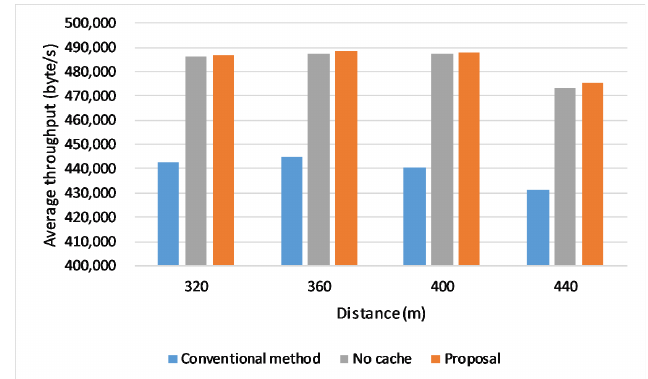
Figure 14. Throughput in different distances between base